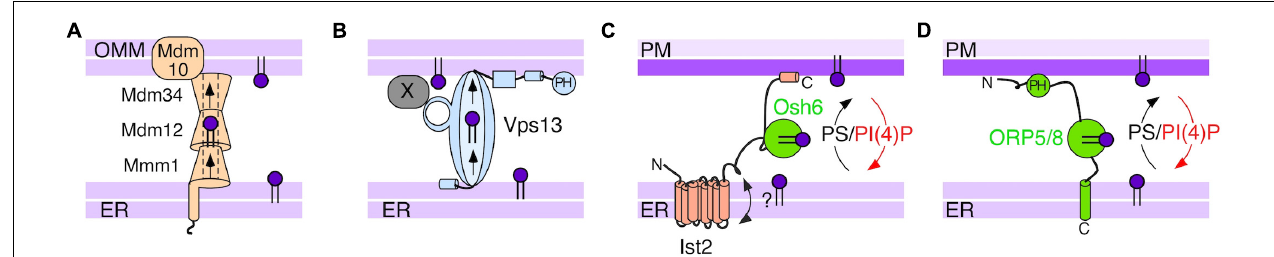
FIGURE 2 | Schematic representation of proteins implicated in PS transfer in the cytosol. (A) The yeast ERMES complex tethers the ER to the outer mitochondrial membrane (OMM) and could mediate passive flow of PS via a hydrophobic tunnel. This model is adapted from Kawano et al. (2017). (B) Vps13 acts as a lipid bridge between the ER and different compartments, which it targets by interacting with compartment-specific adaptors (X). The yeast protein interacts directly with the ER membrane (Dziurdzik and Conibear, 2021). (C) Osh6 in cooperation with Ist2 utilizes the PI(4)P gradient to transfer PS. (D) ORP5 and ORP8 represent the closest mammalian orthologues of Osh6. They use a PH domain and a transmembrane domain to bind to the PM and the ER, respectively.